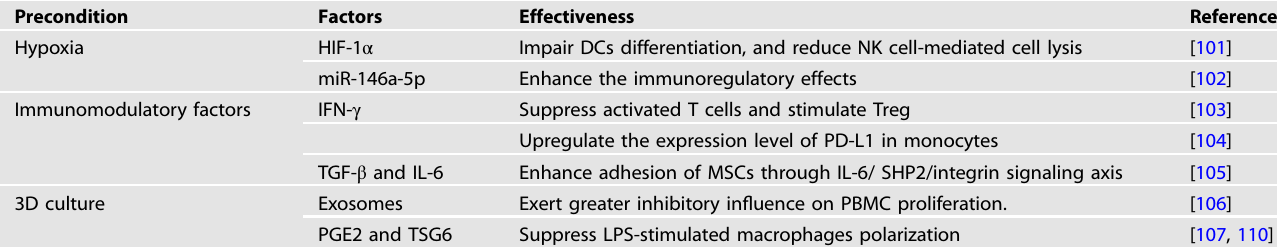
Table 5. Precondition of MSCs to enhance their immunomodulatory function.